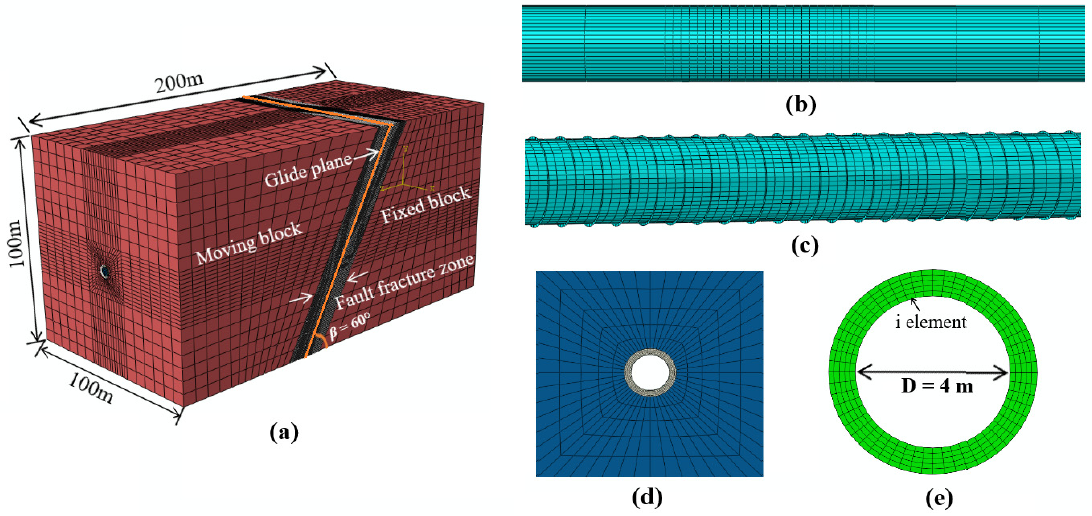
Figure 2. 3D numerical model: ( a ) rock mass mesh; ( b ) concrete mesh; ( c ) stiffened steel tube mesh; ( d ) surrounding rock in x–y plane near tunnel mesh; and ( e ) concrete cross-section element. The surrounding rock and fault fracture zone adopted the ideal elastoplastic Mohr ‒ Coulomb model. The material parameters are cohesion c , Poisson’s ratio ν , the friction angle φ , and the dilation angle ψ . The dilation angle is 1/8 of the friction angle [32], as listed in Table 1. Table 1. Material parameters of the surrounding rock mass.